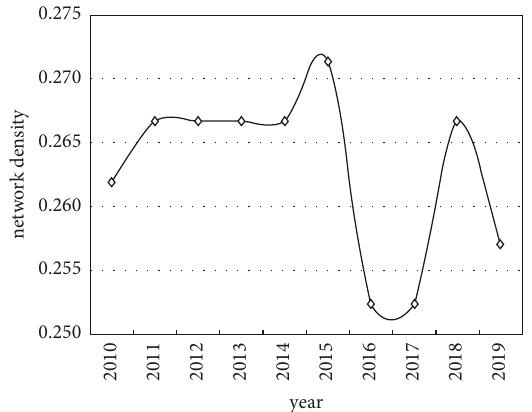
Figure 2: Evolution of network density.